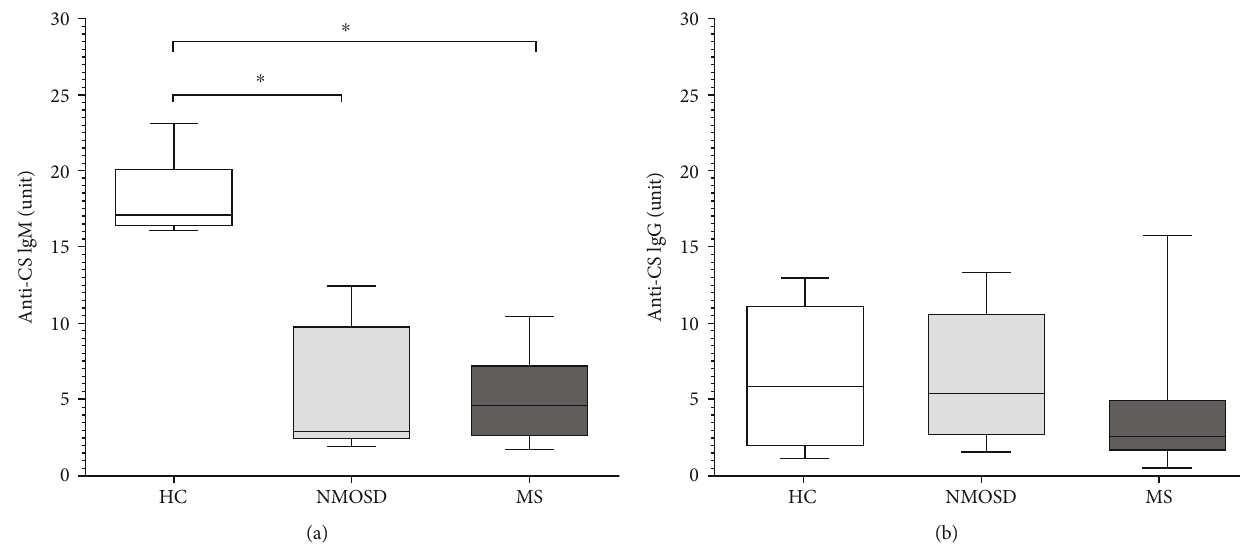
Figure 3: Natural autoantibody serum levels in neuromyelitis optica spectrum disorder (NMOSD) and multiple sclerosis (MS) patients. Anti- citrate synthase (CS) IgM (a) and IgG (b) levels in healthy controls (HC), NMOSD, and MS as measured by ELISA. Boxes show interquartile ranges (IQR); whiskers indicate the lowest and highest values; horizontal lines represent medians; n = 5 HC, n = 10 NMOSD, and n = 13 MS; ∗ p < 0 : 05